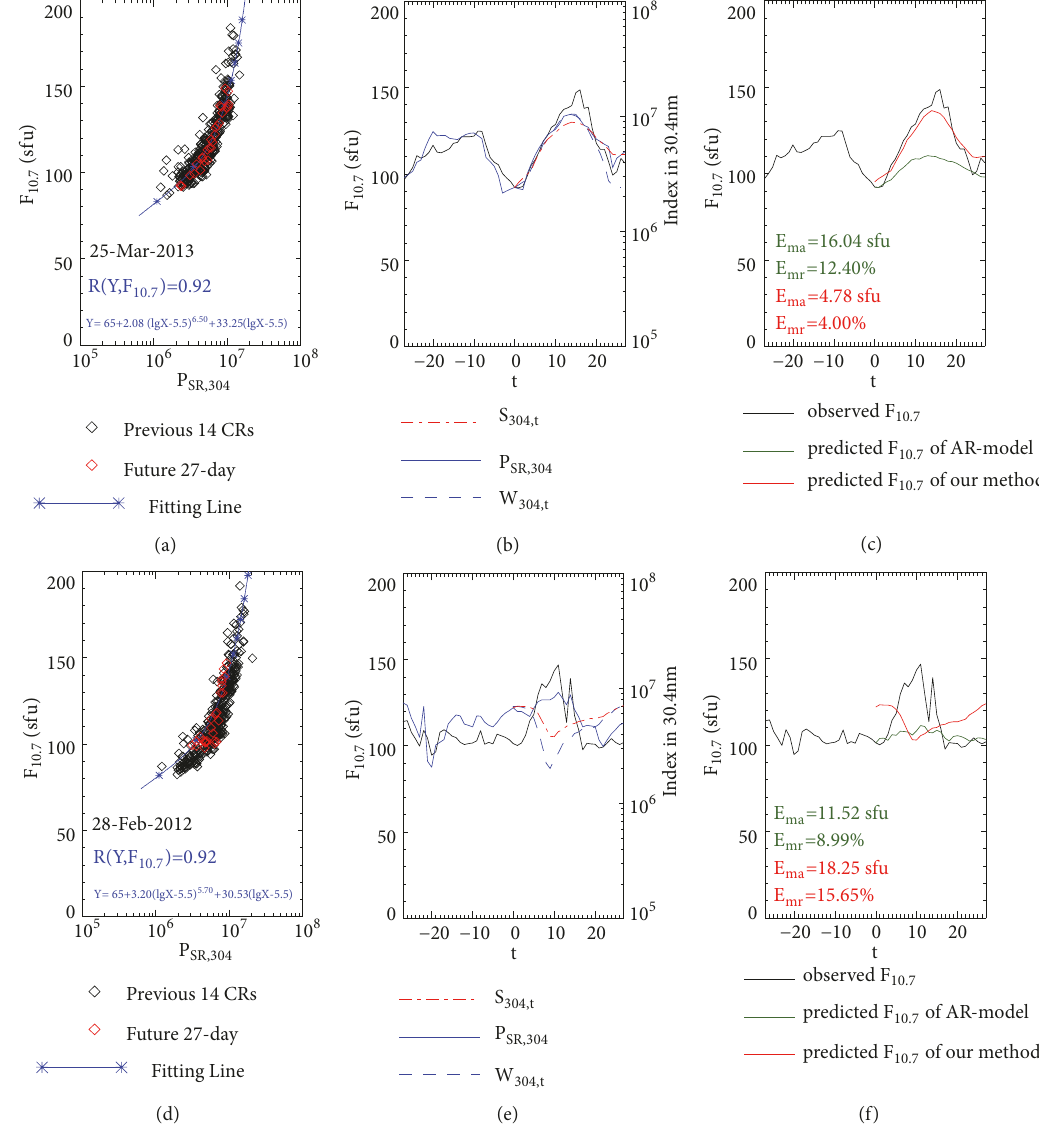
Figure 10: The F 10.7 forecast results of two cases: 25 March 2013 (a, b, c) and 28 February 2012 (d, e, f). (a, d) Scatter diagrams of the 14 CRs’ previous values of F 10.7 and P SR ,304 (black diamonds), and the future 27-day values of F 10.7 and P SR ,304 (red diamonds). The solid blue line with asterisks is the fitted function. R is the correlation coefficient between fitted Y and F 10.7 . (b, e) Comparison of P SR ,304 (solid blue line), W 304 (dashed blue line), S 304 (dashed-dot red line), and F 10.7 (solid black line) in previous (negative value in horizontal axis) and future (positive value in horizontal axis) 27 days of that test date (zero in horizontal axis). (c, f) The value of observed F 10.7 (black line) and predictive F 10.7 obtained from the 54th-order AR-model (green line) and our method (red line) in future (positive value in the horizontal axis) 27